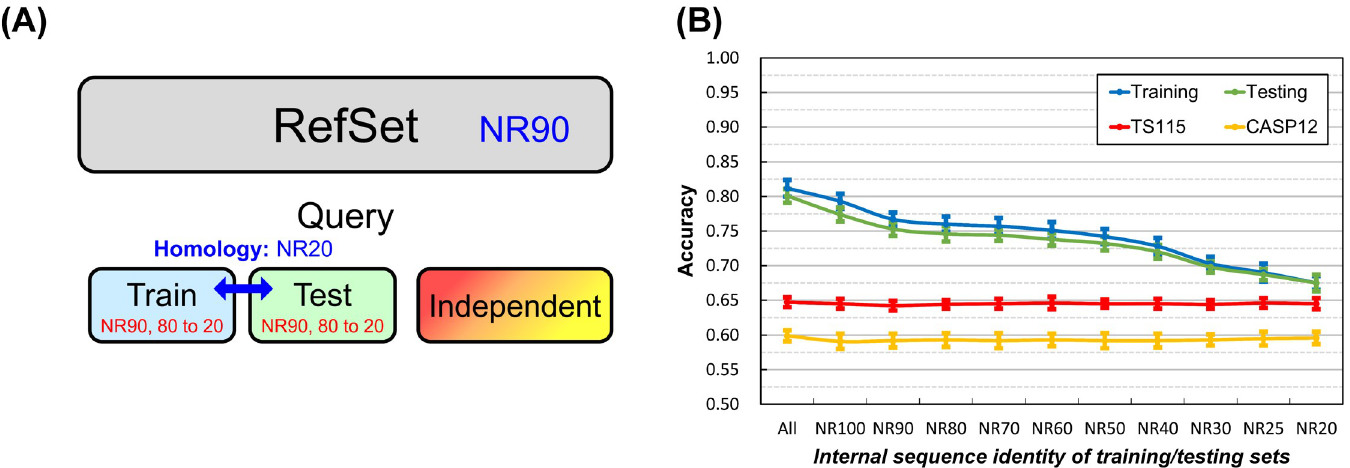
Fig 2. Effects of the homology within the training/testing query dataset on the accuracy of secondary structure prediction. (A) The layout of datasets. The homology between training and testing query datasets was fixed, while the homology within each query dataset decreased. Dataset size: reference 10,000, training 250, testing 250; independent test dataset TS115: 115, CASP12: 46. (B) Results of fixed inter-dataset homology ( < 20% identity) with decreasing inner-dataset homology. The accuracy of independent tests remained steady as training and testing query sets’ inner-dataset homology decreased; meanwhile, the accuracy of training and testing was remarkably decreased. Since the accuracy of independent test represents the practical accuracy when an SSP method faces query proteins very different from those it had learned, the fact that the accuracy of training/testing approached the accuracy of independent test indicated a reduction of overfitting. This experiment revealed that although the homology within training and testing query sets has little influence on the practical accuracy of SSP, lowering it can greatly reduce overfitting. See S2 Fig for the same trend in SOV.